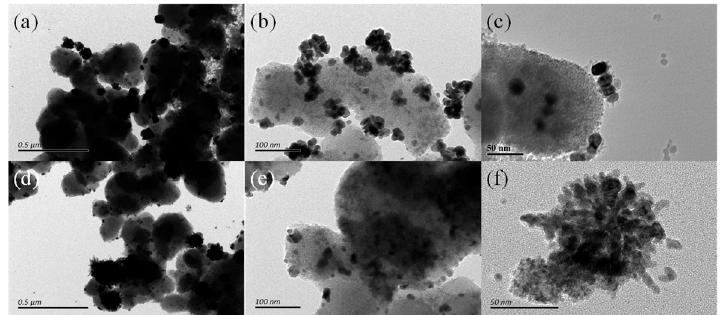
Figure 3. Electric field ‐ assisted fs laser liquid phase ablation to prepare Au@TiO 2 composite mate ‐ rials. ( a – c ) TEM images of AuNCs@TiO 2 prepared by electric field ‐ assisted fs laser; ( d – f ) TEM im